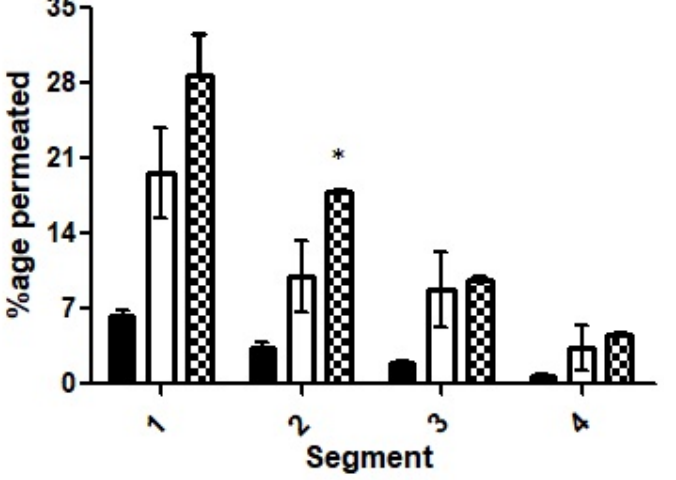
Figure 11. Penetration capacity of ACV while an aqueous solution (black bars), loaded into selected formulation F7 (white bars) and loaded into OC-PAP formulation (dotted bars) analyzed via rotating silicon tube method for 4 h. * indicates that the outcomes of F10 are significantly different than F7.